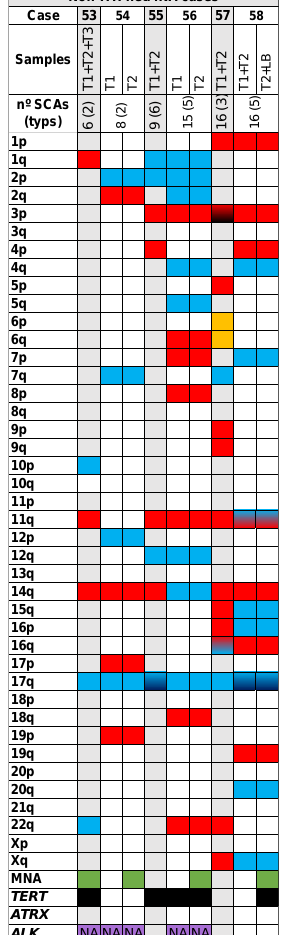
Figure 3. Genomic aberrations found by SNPa in cases with heterogeneous MYCN amplification (hetMNA). In the upper part the number of the analysed samples (T: solid tumour -1, 2, 3-; LB: liquid biopsy) corresponding to each case (53–58) with the total number of SCAs and the typical ones in parenthesis, are shown. Solid blue or red squares refers to gains or losses, respectively in the indicated chromosome arm. Gradient color from blue or red to black indicates gains or losses with 2 or more chromosome fragments in the chromosome arm. Gradient color from blue to red refers to both gains and losses in the same chromosome arm of a sample. Solid yellow squares indicate presence of chromotripsis-like phenomenon. Green squares indicate MYCN amplification detection by SNPa. Black squares indicate presence of focal segmental chromosomal aberrations (FSCAs) affecting TERT or ATRX genes. Purple squares indicate that the samples have been analysed for alternative lengthening of telomeres (ALT) or for mutations and amplifications in ALK gene; NA: in the squares indicates that any aberration has been detected in the sample.